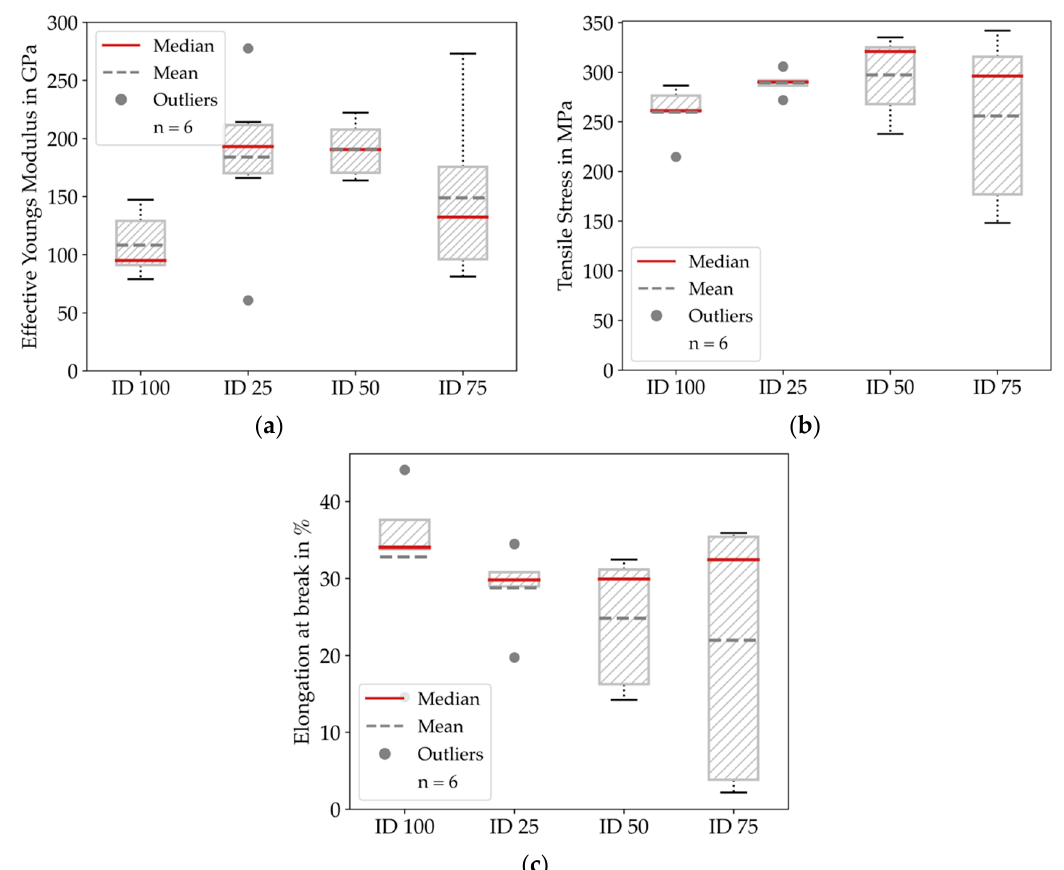
Figure 11. Results of the tensile testing experiments clustered by infill degree: ( a ) Effective Young’s modulus for all configurations; ( b ) Tensile stress for all configurations; ( c ) Elongation at the break for all configurations. The results show high deviations between the specimens, we could also tune the effective Young’s Modulus within the range of 108 to 191 GPa.